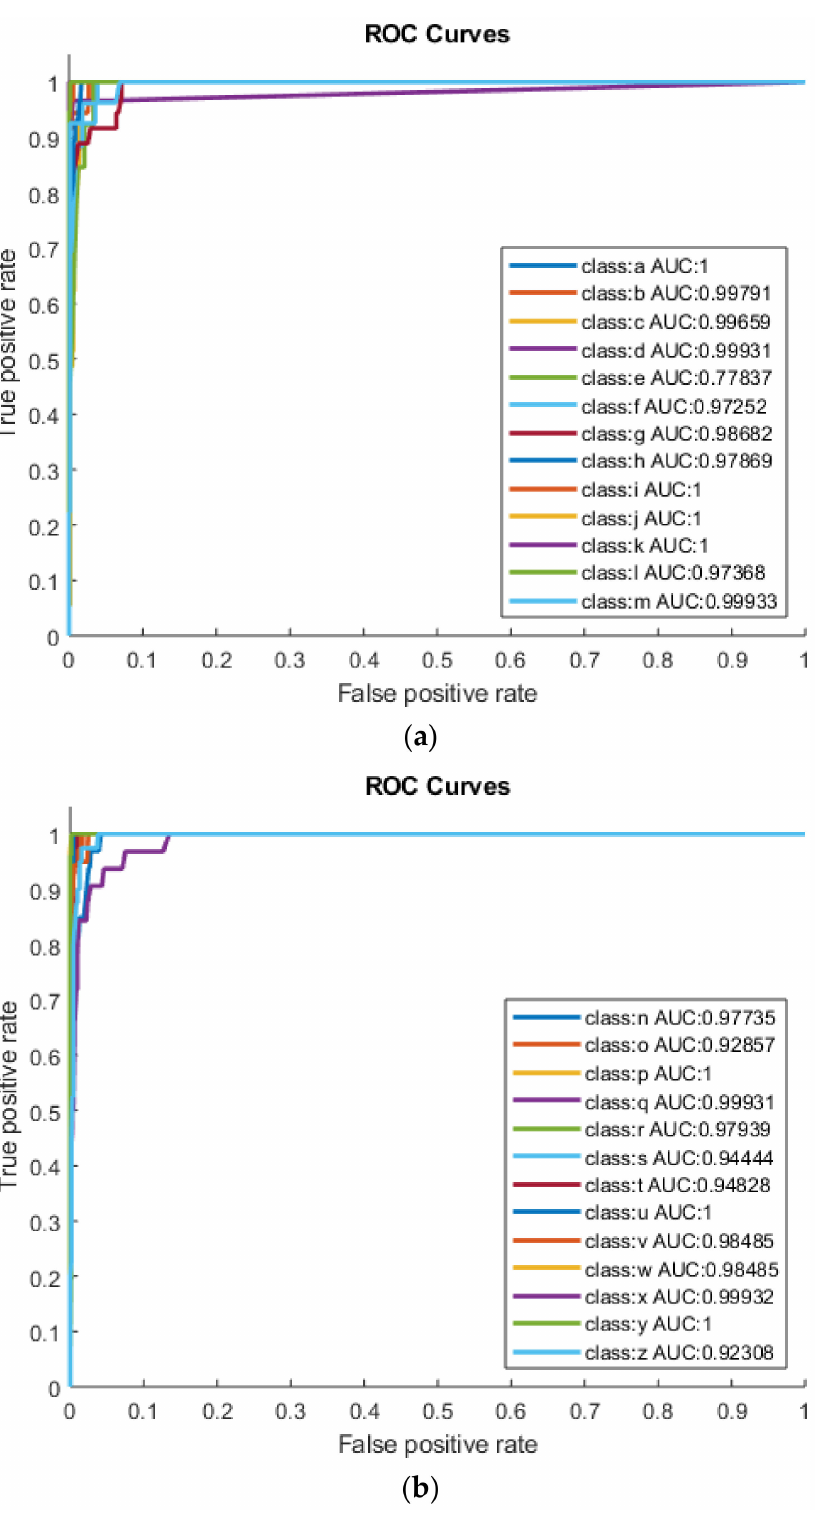
Figure 4. ( a ) Category-1 (a–m) using KNN and ( b ) category-2 (n–z) using